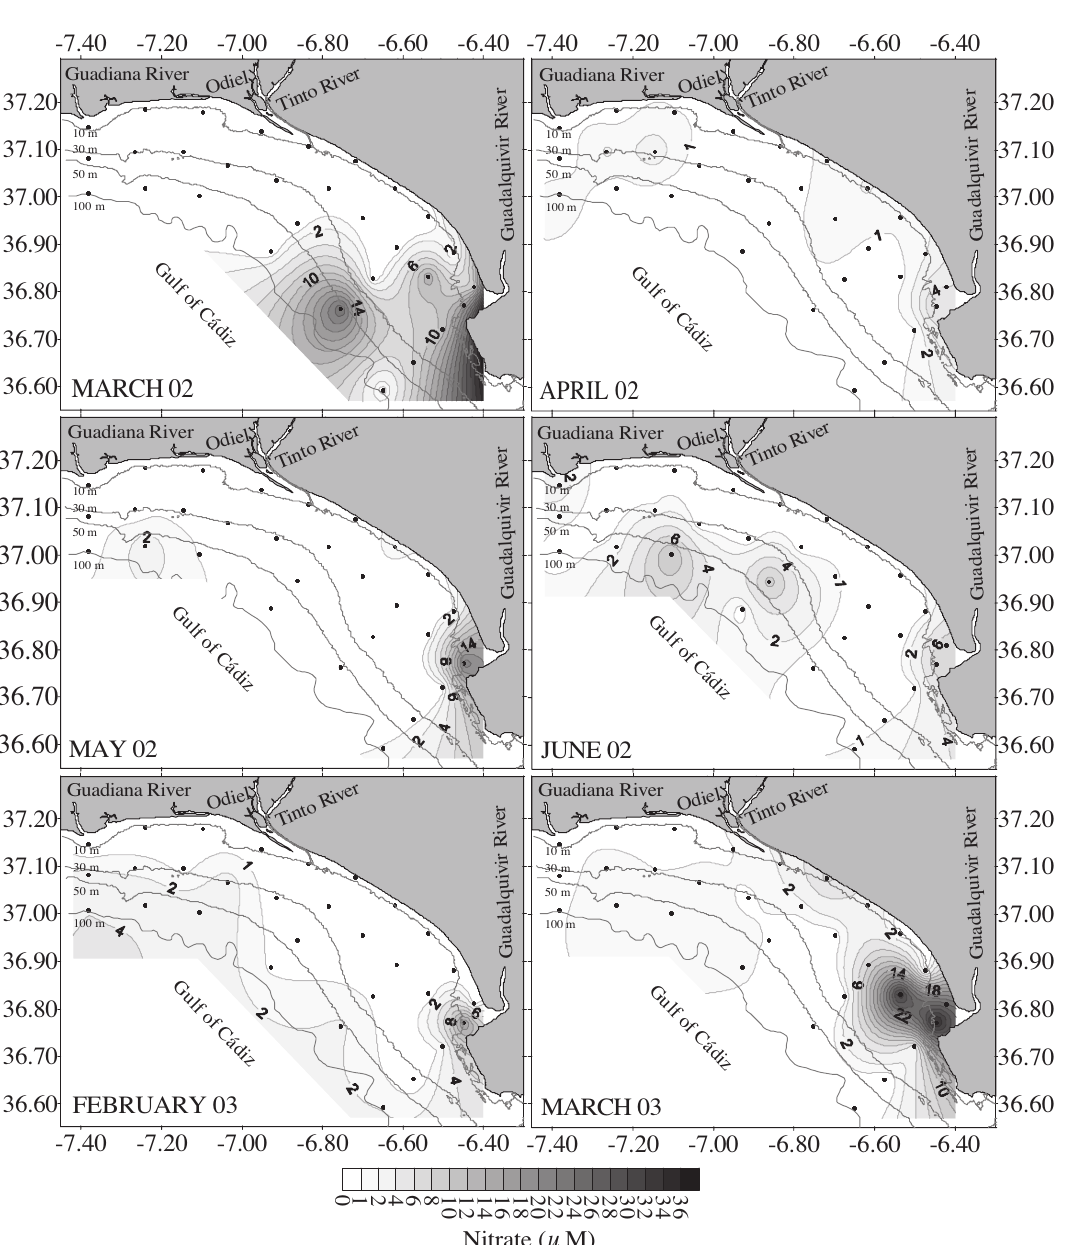
F IG . 11. – Nitrate (µM) distribution during the wedge sole main reproduction